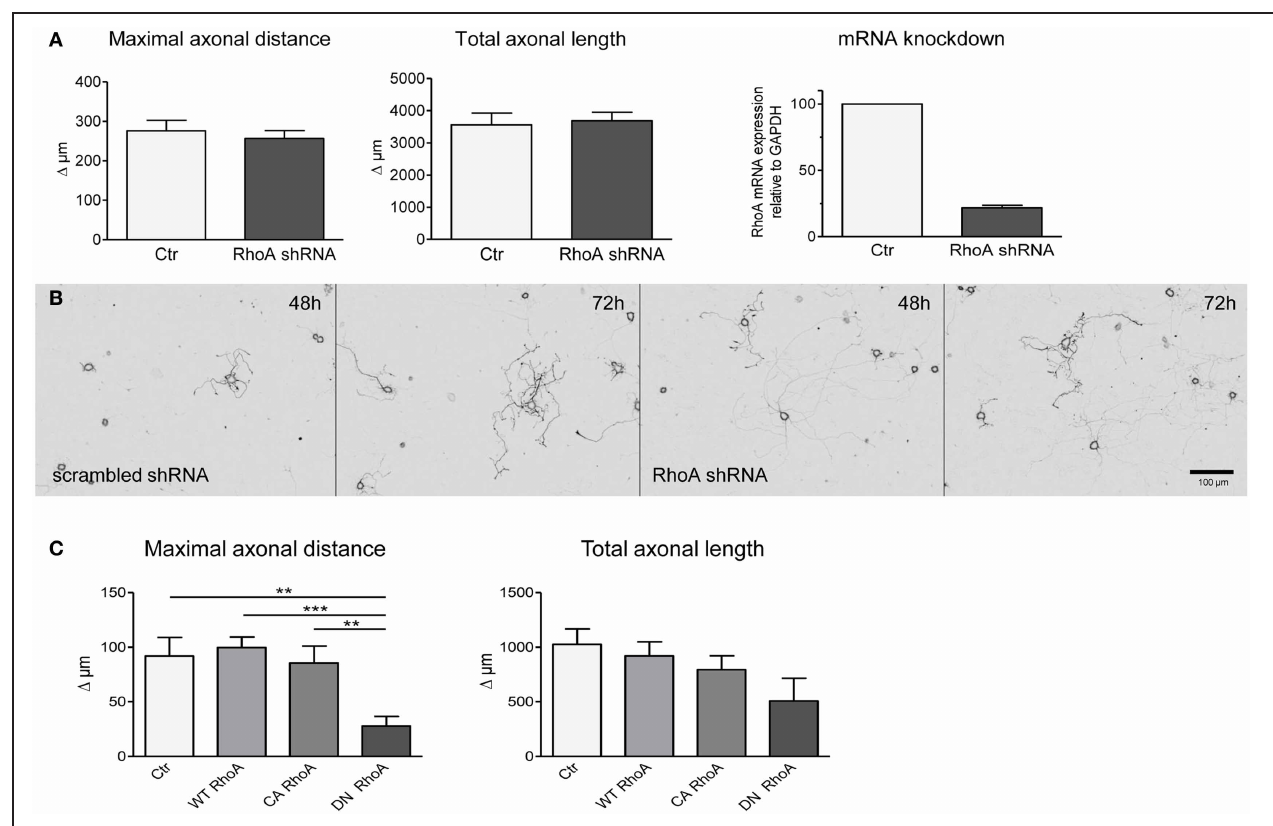
PCR, n = 3). DRG neurons transfected with a plasmid encoding dominant negative (DN) RhoA together with a marker plasmid exhibit a decreased maximal axonal distance with a statistically unaltered total axonal length (C) . Constitutively active (CA) or wildtype RhoA do not alter axonal growth in fluorescent cells (total number of neurons per group > 77, three independent experiments, mean ± SEM; ∗∗ p < 0 . 01, ∗∗∗ p < 0 .